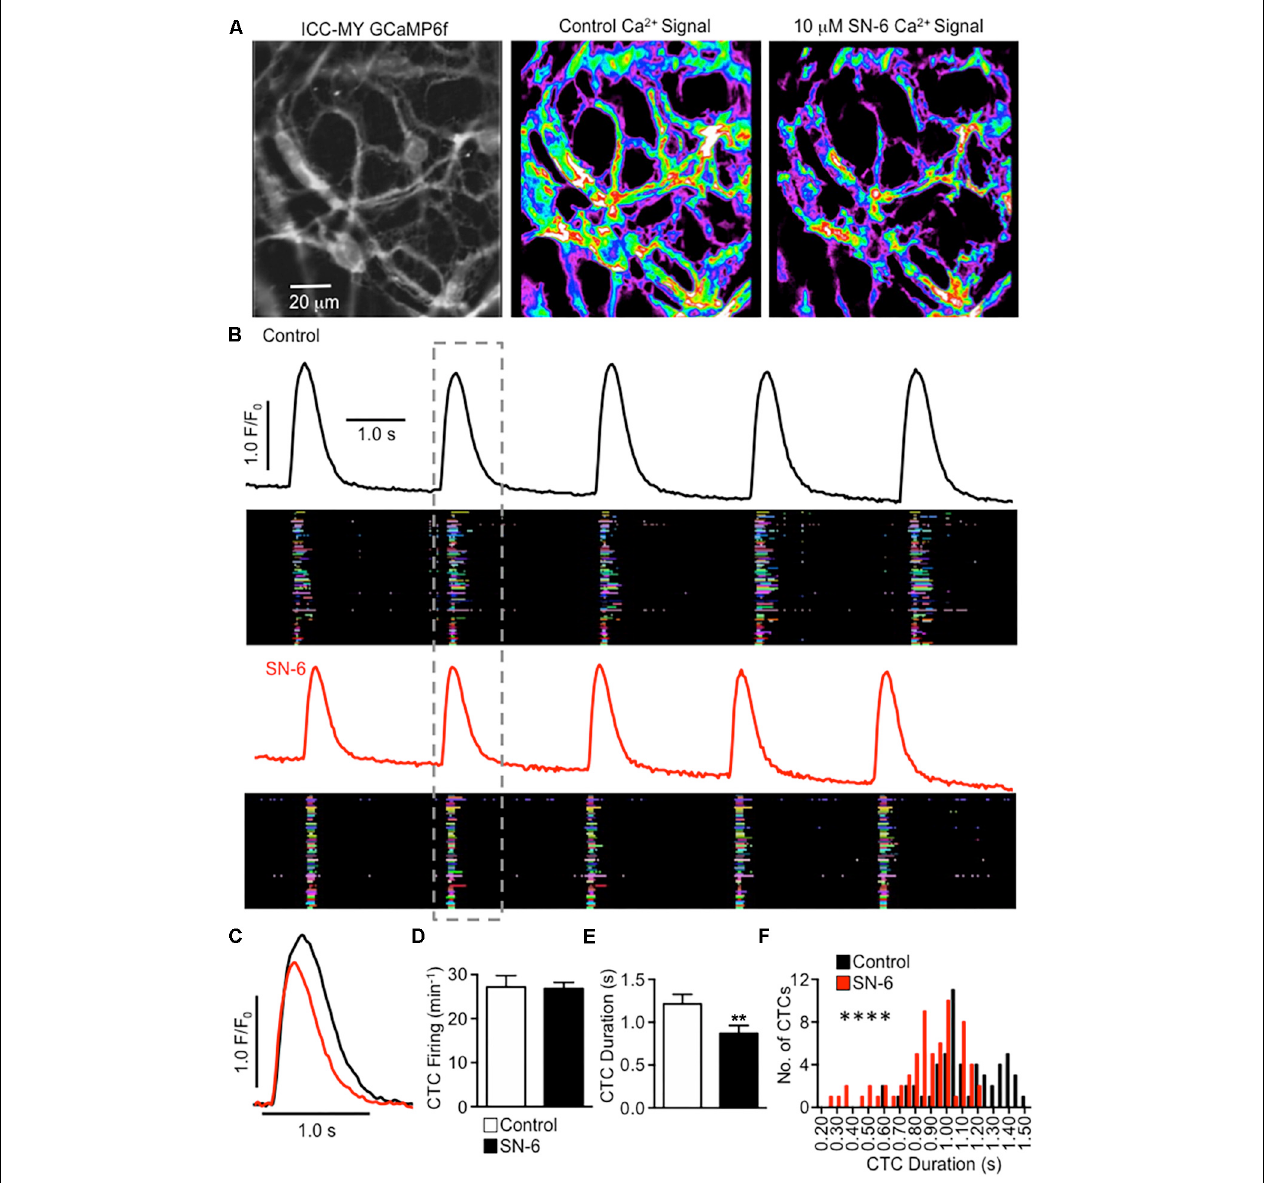
FIGURE 9 | Inhibiting NCX decreases the duration of Ca 2 + transient clusters in ICC-MY networks. (A) Raw image of an ICC-MY network recorded from the jejunum of a Kit-Cre-GCaMP6f mouse (far left panel). The summated heat map of all Ca 2 + transients that occurred in this field of view (FOV) over a 30 s recording is shown before and after addition of SN-6 (10 µ M) in the middle and far right panel, respectively. (B) Traces of summated Ca 2 + activity in the ICC-MY network before (black) and after (red) addition of SN-6 (10 µ M). Occurrence maps show the activity of each individual firing site within the ICC-MY network plotted against time, with each firing site in the network plotted as a differently colored lane. The number of colored lanes (counted along the y -axis) indicates the number of active firing sites. The width of each lane (measured along the x axis) at any point indicates the duration that the site was active. Note that under control conditions, many sites fired multiple Ca 2 + transients during each cycle, but after SN-6, the number of occurrences at each site decreased to only a single event. (C) Expanded timescale showing a single CTC highlighted in the dashed gray box in (B) , before (black) and after (red) addition of SN-6 (10 µ M). (D) Summary effect of SN-6 (10 µ M) on CTC firing frequency, n = 6. (E) Summary effect of SN-6 (10 µ M) on CTC duration, n = 6. ** p < 0.01. (F) Histogram showing the distribution of values for CTC duration before (black) and after (red) addition of SN-6 (10 µ M; n = 6). **** p <